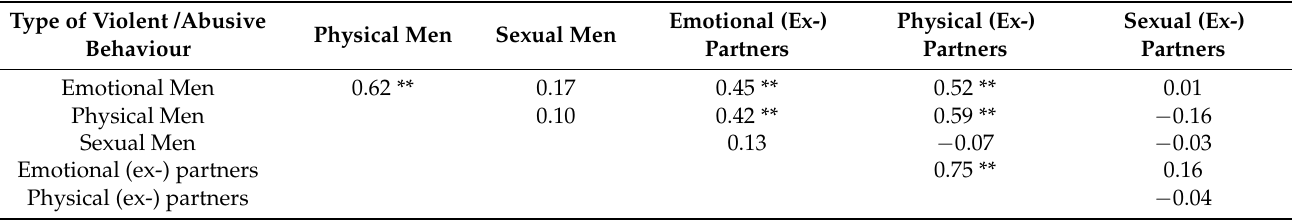
Table 4. Correlations among the frequency of the three types of violent behaviours of both groups.